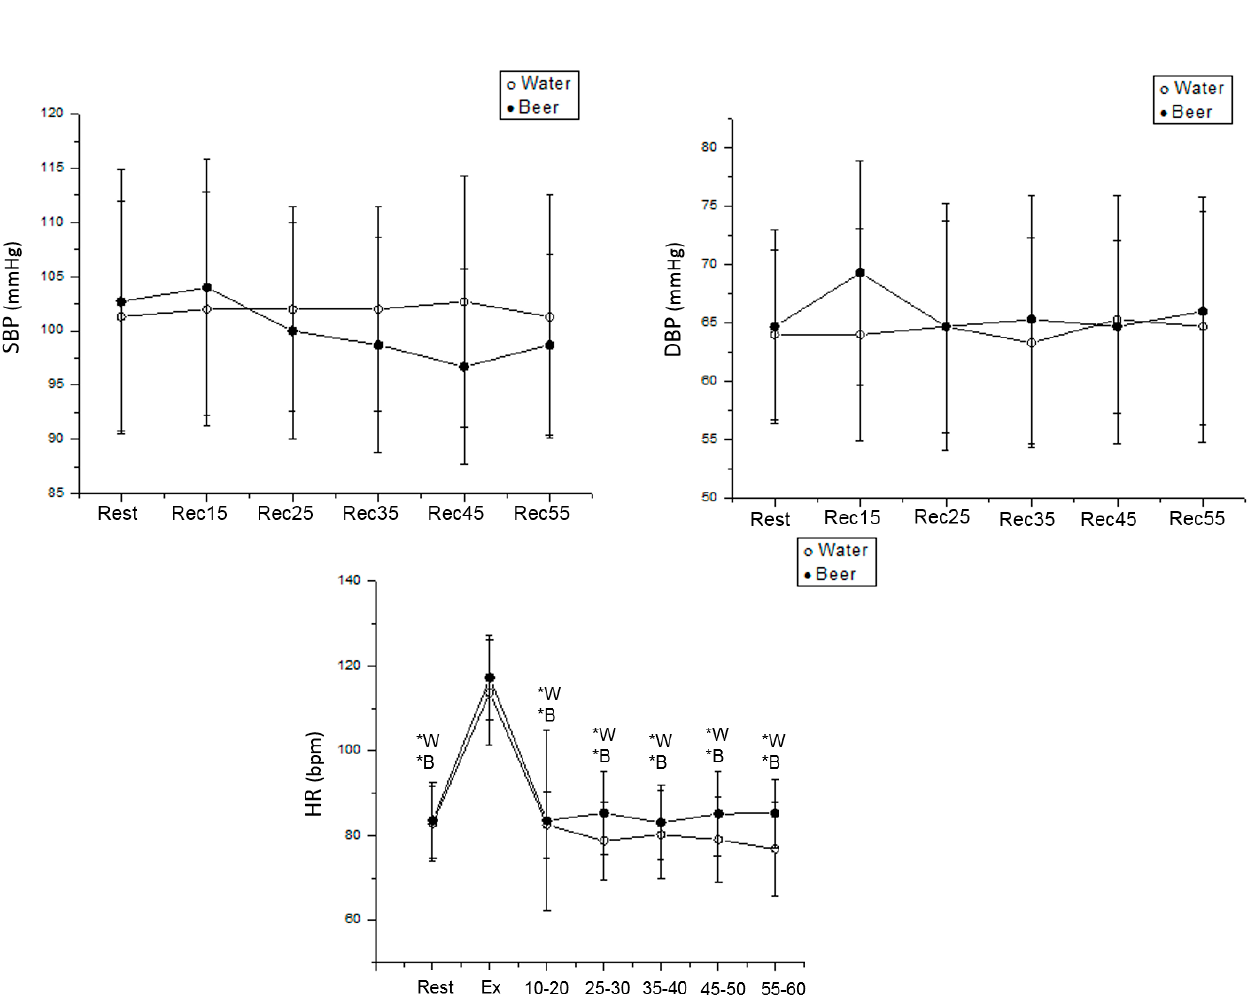
Figure 4. HR, SBP and DBP values were obtained at rest and during recovery from moderate aerobic exercise protocol in women. *W: Values with significant differences in relation to exercise ( p < 0.01) for water protocol; *B: Values with significant differences in relation to exercise ( p < 0.01) for beer protocol.